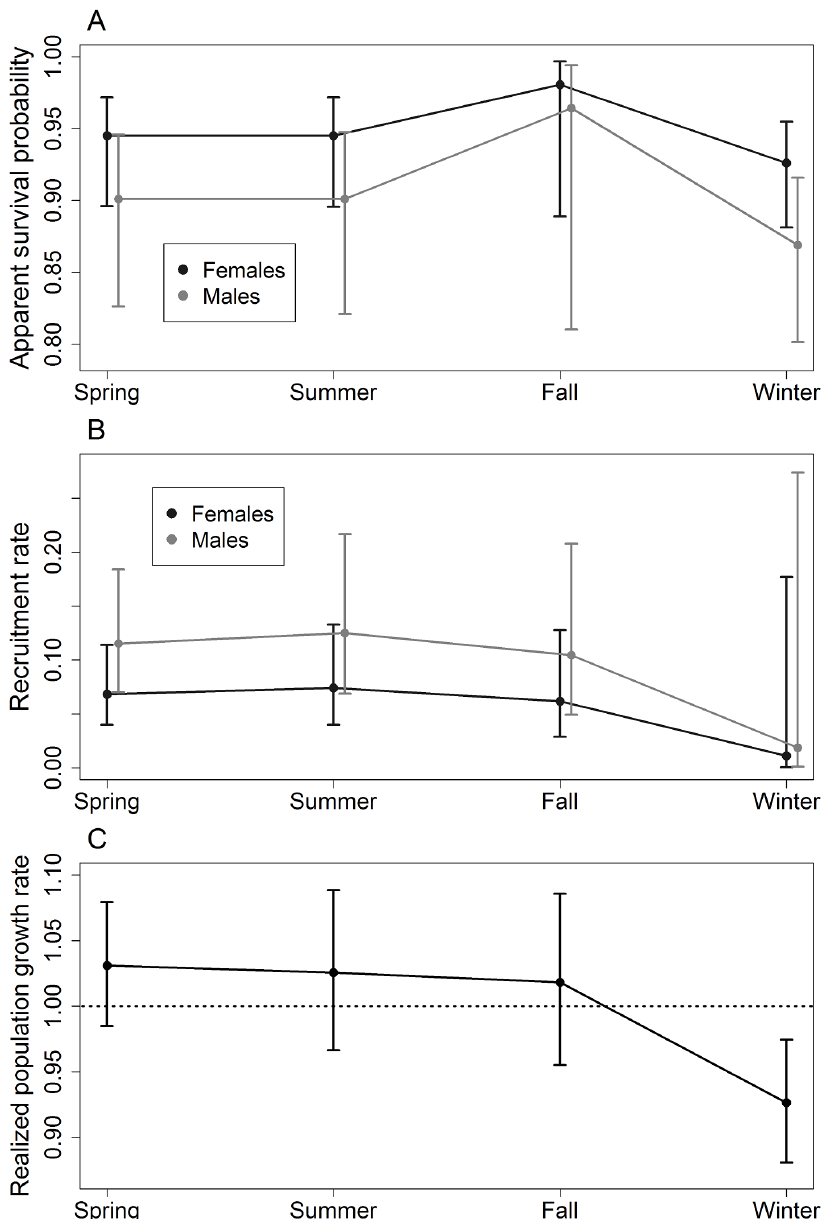
Figure 2. (A) Monthly apparent survival probability, (B) monthly recruitment rate, and (C) monthly realized population growth rate of northern raccoons ( Procyonlotor ) at the Ordway-Swisher Biological Station, Florida. Estimates and 95% confidence intervals are from the top-ranked model that included season for each parameter: { Q (season + sex) p (month + sex) l (season)} for survival, { Q (sex) p (month + sex) f (season + sex)} for recruitment, and { Q (sex) p (month + sex) l (season)} for population growth rate.